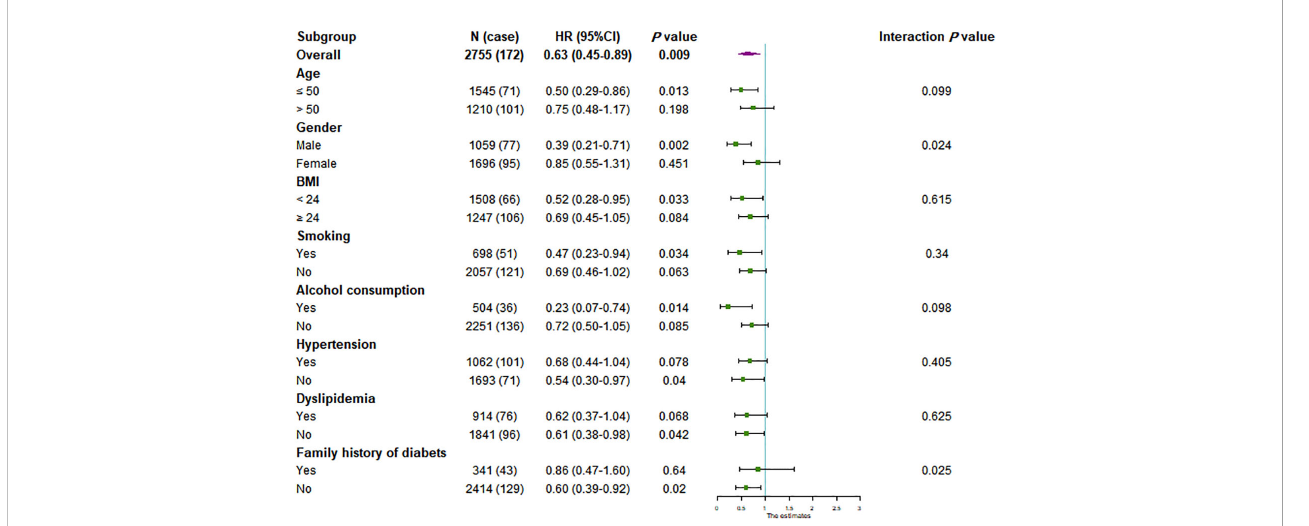
FIGURE 1 Subgroup analysis of the association between LXA4 and the incident of T2DM. Cox regression after adjustment for baseline age, gender, BMI, smoking, alcohol consumption, hypertension, dyslipidemia, hs-CRP, family history of diabetes and physical activity was performed in subgroups according to age ( ≤ 50 or > 50 years), gender (male or female), body mass index (BMI; < 24 or ≥ 24 kg/m2), smoking (yes or no), alcohol consumption (yes or no), hypertension (yes or no), dyslipidemia (yes or no), and family history of diabetes (yes or no).